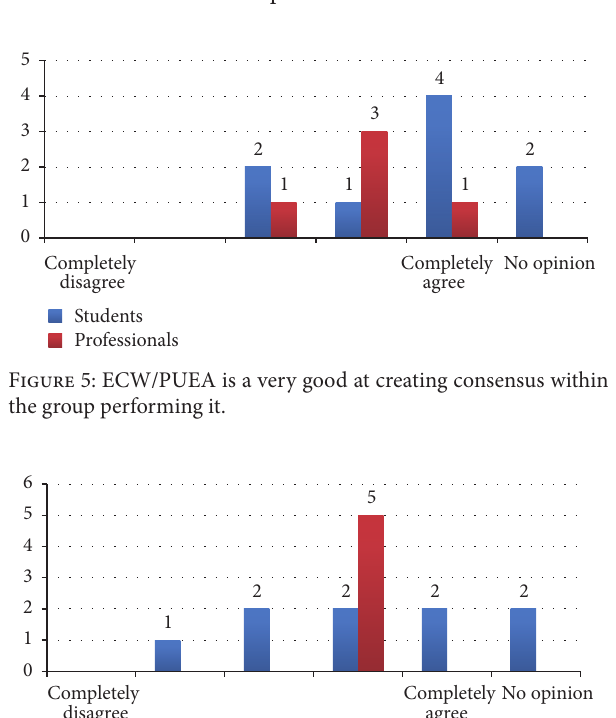
students’ opinions were more distributed (Figure 6). This might be explained by that the professionals used ECW/ PUEA together as one group, while students worked in dif- ferent groups.